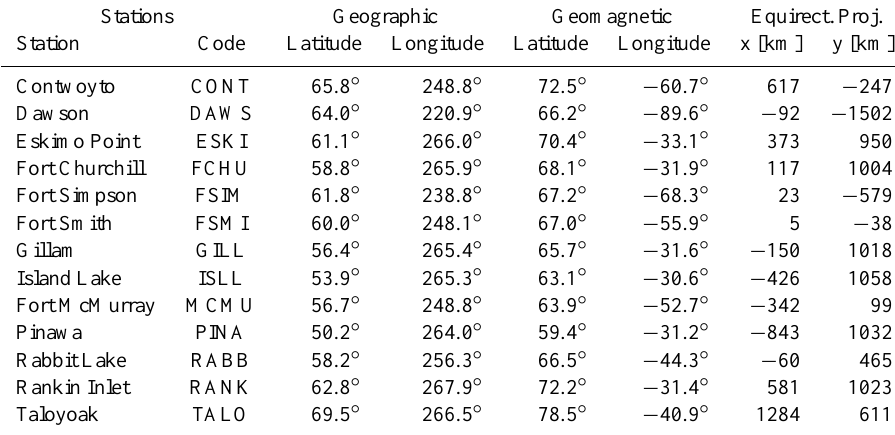
Table 1. The coordinates of the 13 CANOPUS stations in geographic and geomagnetic coordinate systems and in the equirectangular projection of the geomagnetic coordinate system.